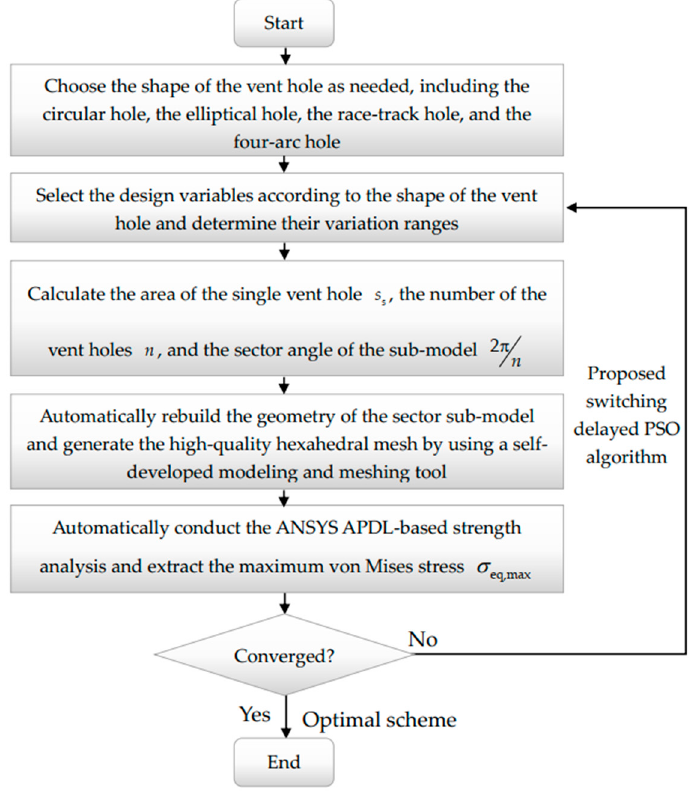
Figure 3. Flowchart of the developed integrated design optimization method. Figure 3. Schematics of four different shape designs for the vent hole. ( a ) Circular hole; ( b ) Elliptical hole; ( c ) Race-track hole; and ( d ) Four-arc